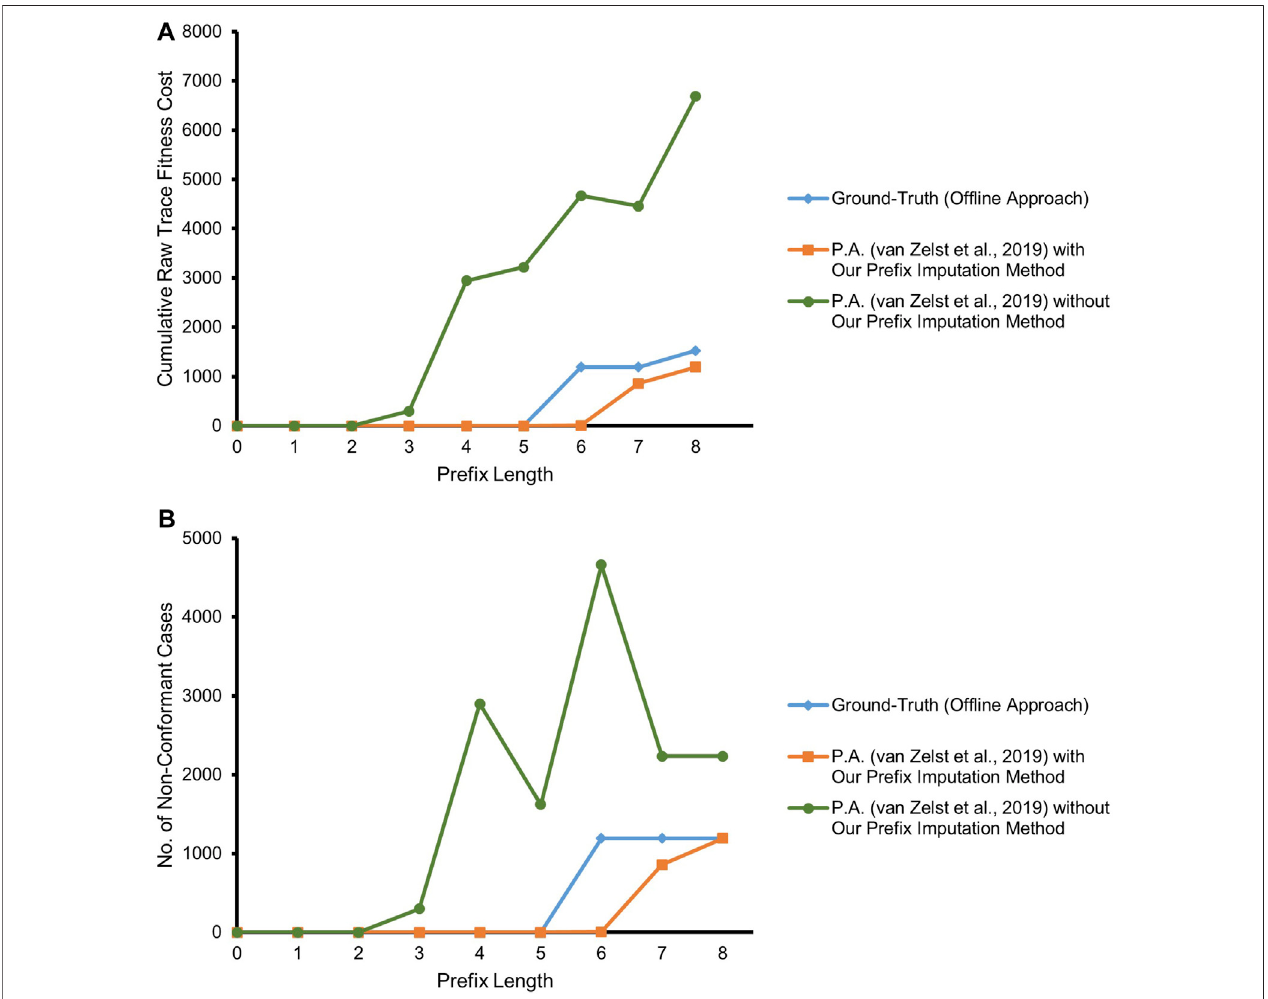
FIGURE7| Pre fi x-alignmentswithandwithoutourpre fi x-imputationmethodforthe application processoftheBPIC ’ 12eventdata. (A) Cumulativerawtrace fi tness cost. (B) Number of non-conformant cases.